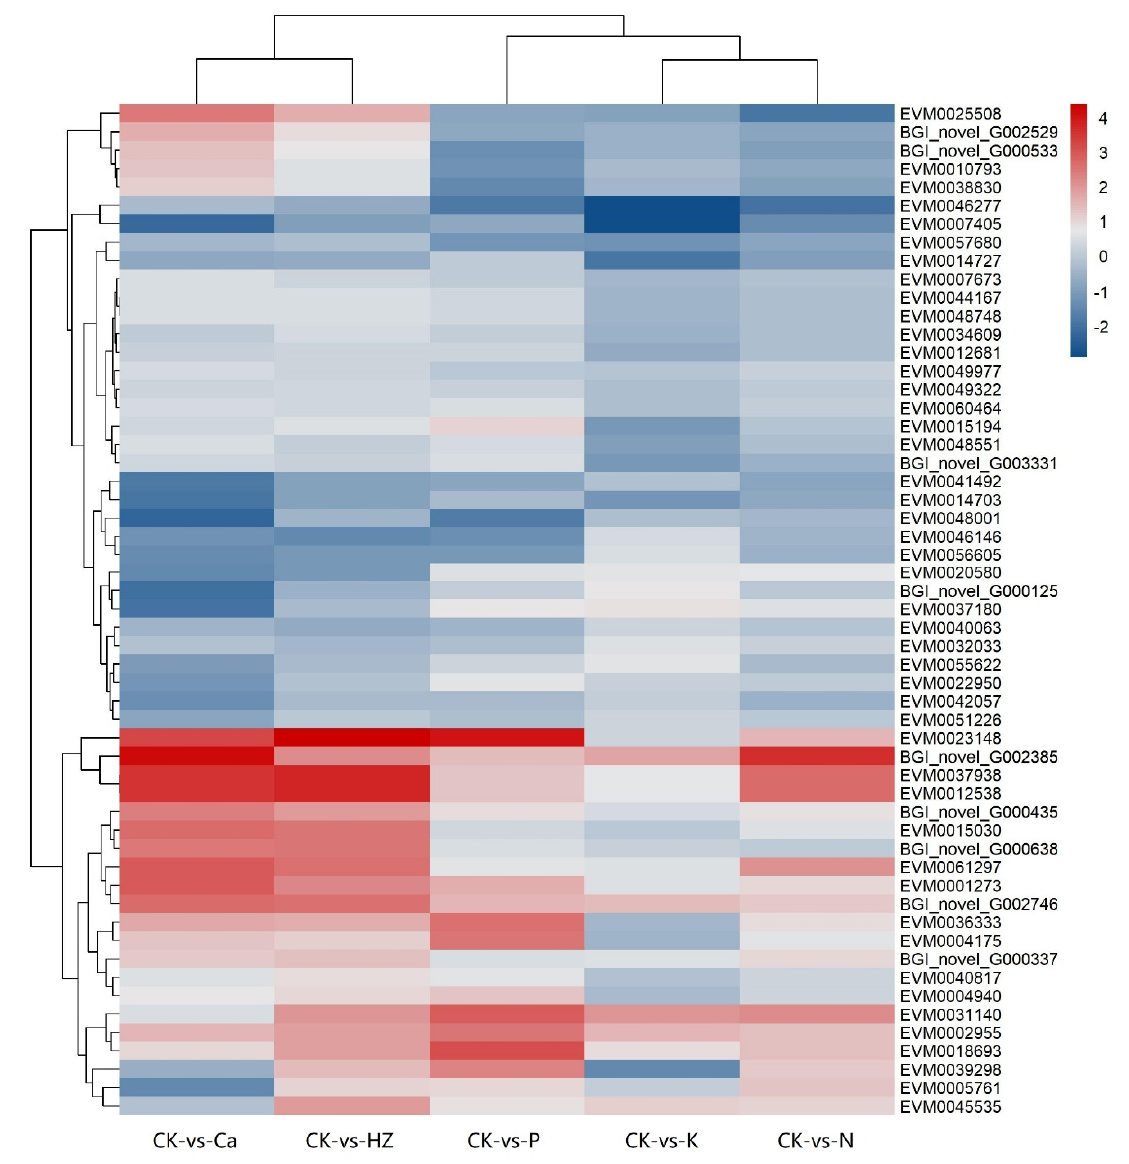
Figure 4. Clustering of differentially expressed insect-defense response genes. Each color reflects the expression level, FPKM with log2 in sample genes, and each row represents one sample. The results in the red region indicate up-regulated genes, whereas the blue area indicates down-regulated